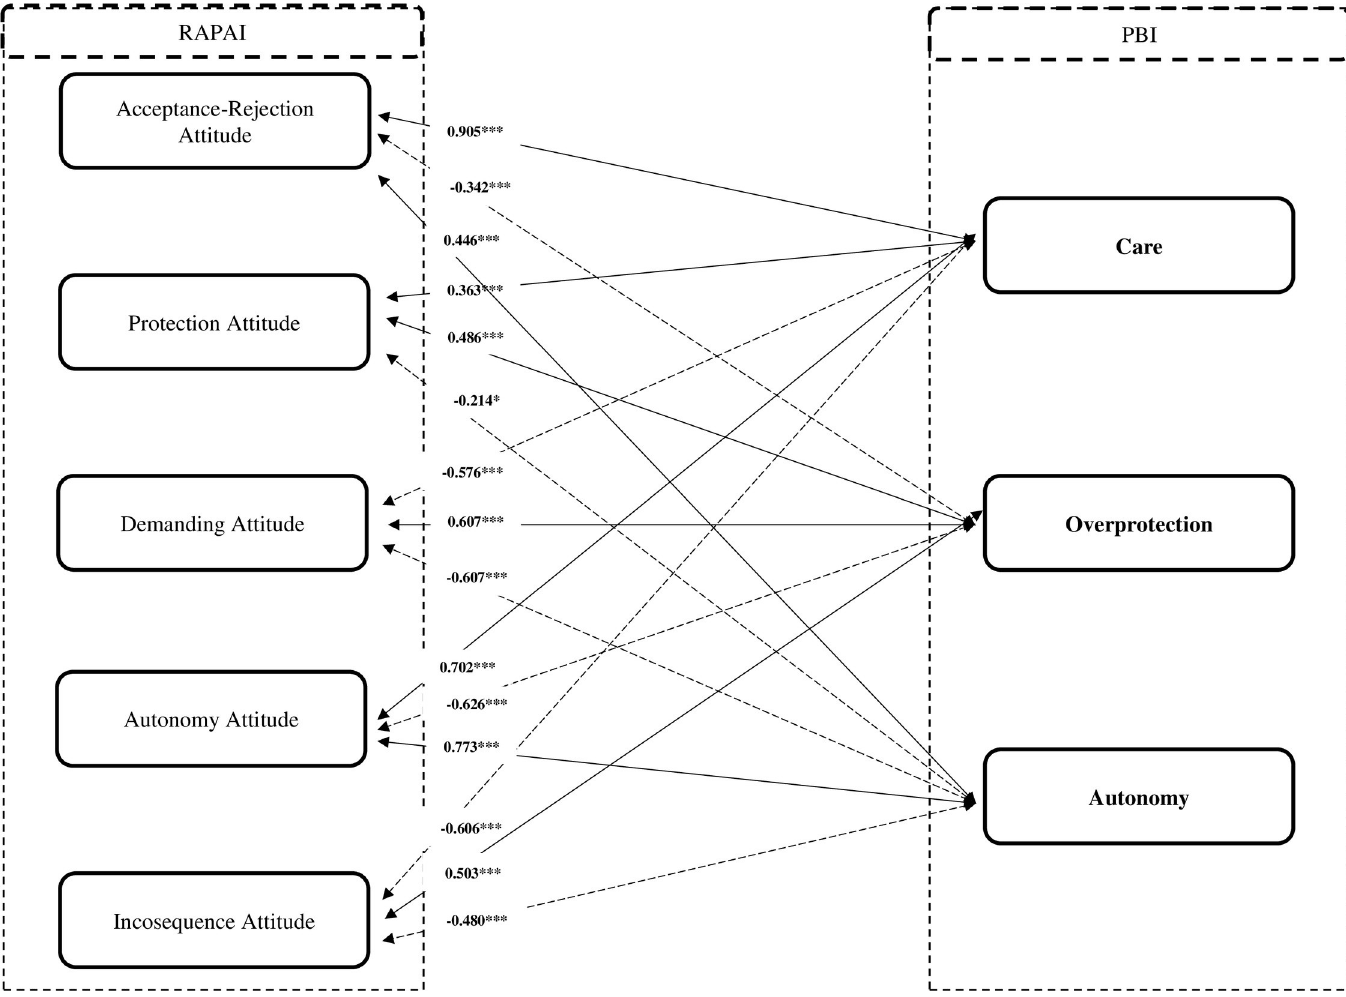
Fig 2. Correlation analysis for PBI dimensions and RAPAI dimensions for mother. Note: PBI–Parental Bonding Instrument; RAPAI: Retrospective Assessment of Parents’ Attitudes Inventory; � p < 0.05; ��� p < 0.001.